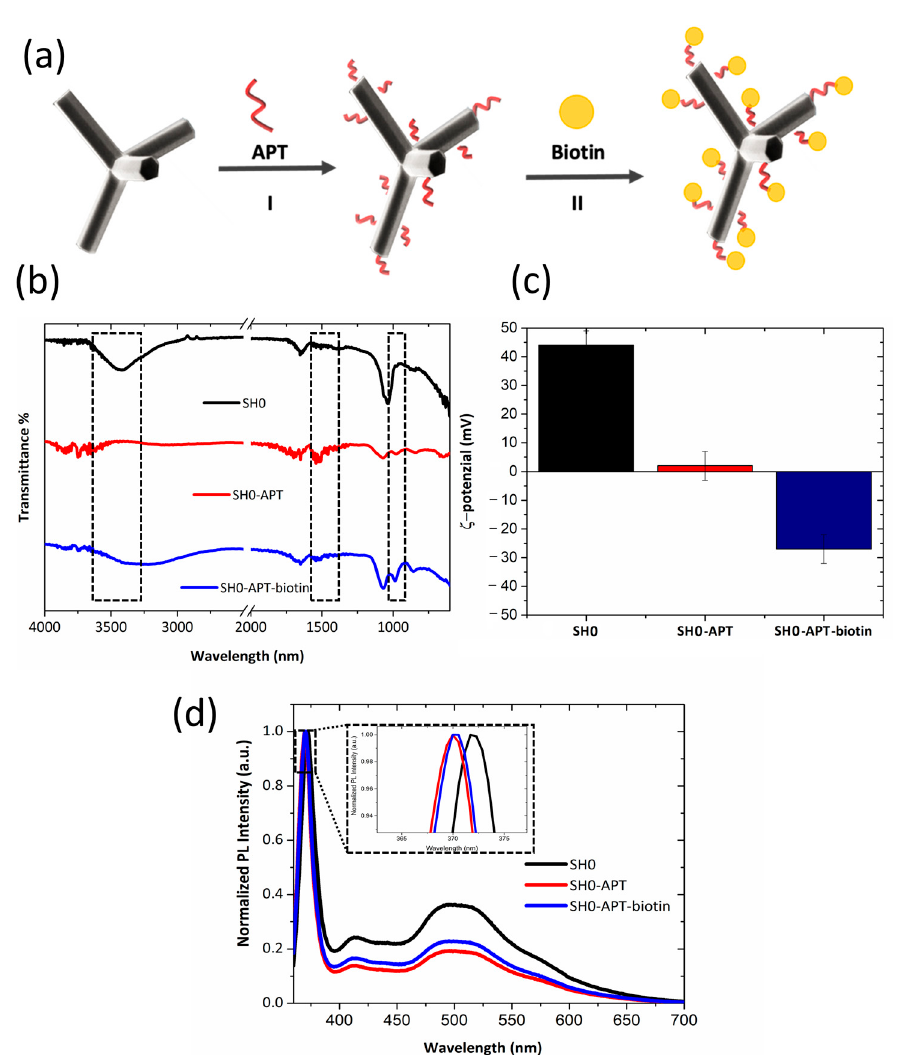
Figure 5. ( a ) Schematic representation of the ZnO-T surface functionalization with APT ( I ) and biotin ( II ). ( b ) FTIR spectrum of ZnO-Ts after each step of functionalization. ( c ) ζ -potential analysis. ( d ) PL spectra of ZnO-Ts before and after the surface